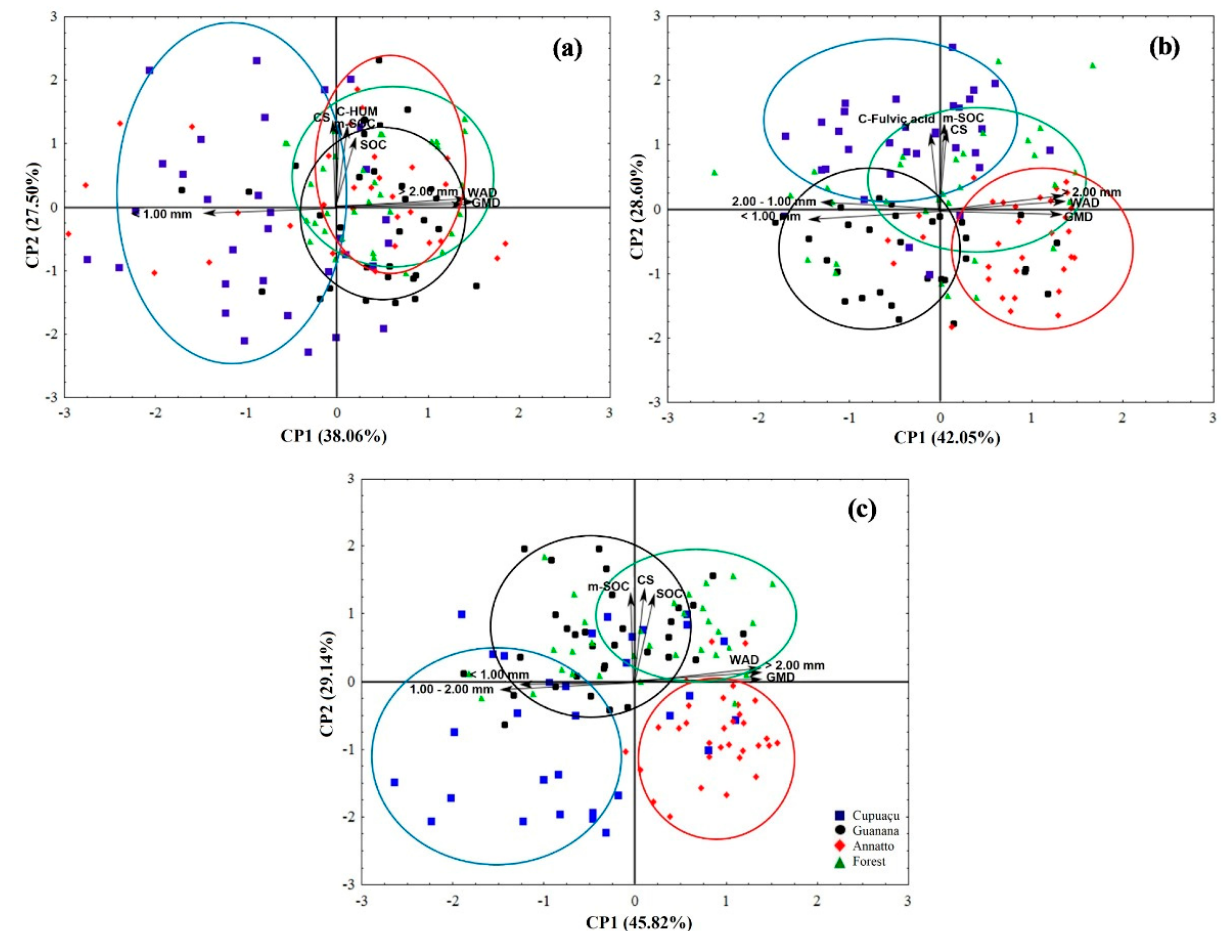
Figure 1. Principal component analysis (PCA) score plot for land use, soil traits, and soil organic matter compartments in the 0–5 ( a ), 5–10 ( b ), and 10–20 cm ( c ) as influenced by land use in Brazil’s Legal Amazon. Polygons represent land use. Two axes represent 65.56, 70.65, and 75.16% of the data variance at 0–5, 5–10, and 10–20 cm,